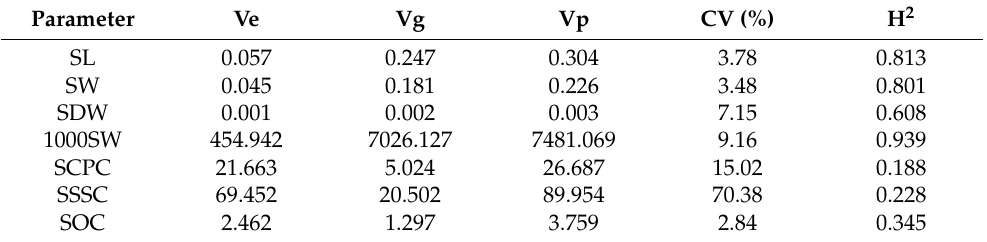
Table 3. Variances and broad-sense heritability of seed parameters in X. sorbifolium .